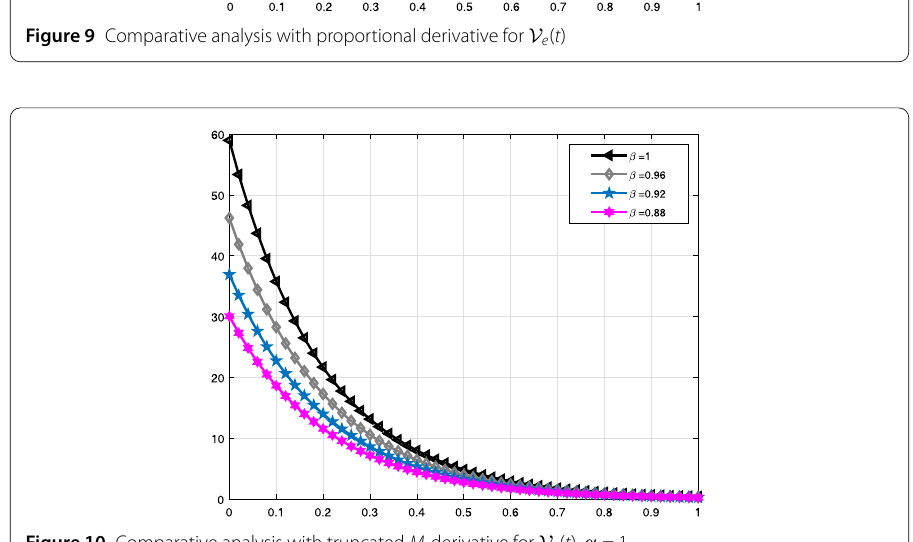
Figure 10 Comparative analysis with truncated M -derivative for V e ( t ), α = 1